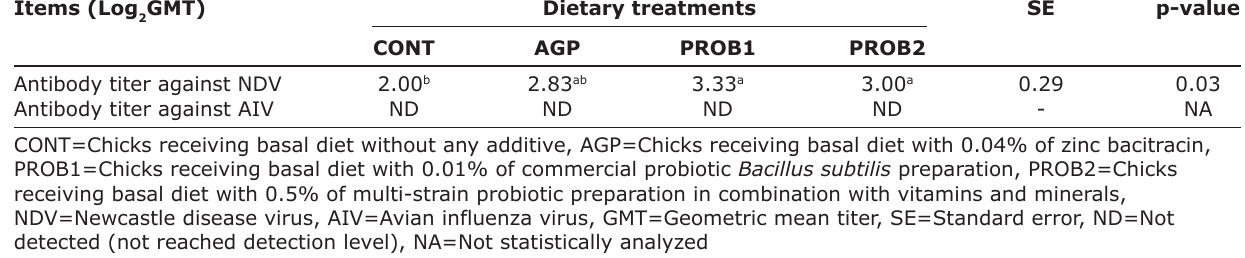
Table-5: Effect of multi-strain probiotic preparation in combination with vitamins and minerals on antibody titer against NDV and AIV of Indonesian indigenous crossbred chickens. Items (Log GMT) 2